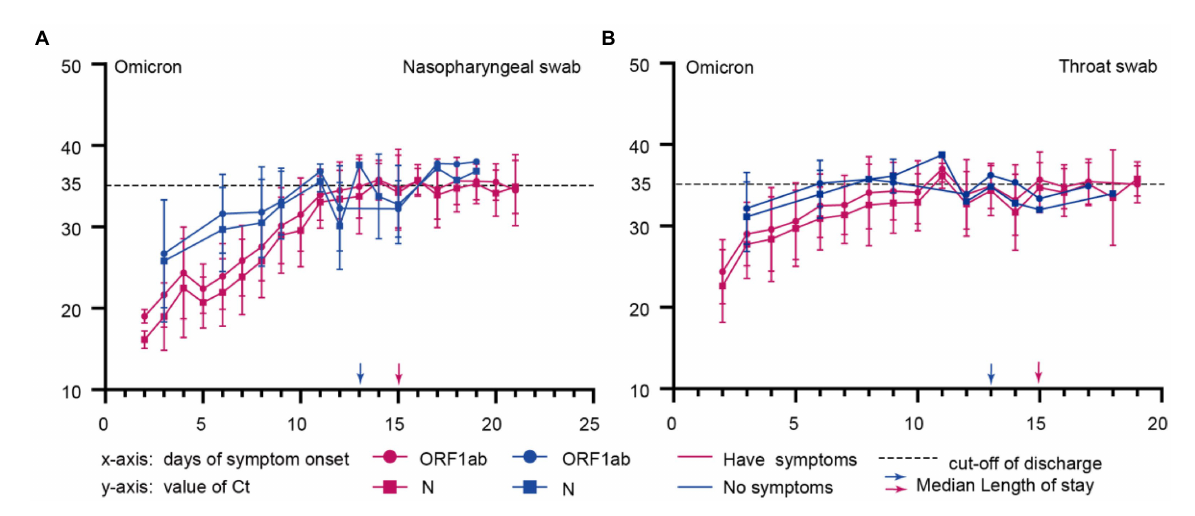
FIGURE 3 Comparison of Ct dynamic changes in omicron-infected patients with symptoms or no symptoms. (A) , Nasopharyngeal swabs of Omicron infected patients with symptoms or no symptoms; (B) , Throat swabs of Omicron infected patients with symptoms or no symptoms; The x-axis represents the time of disease course since symptom onset, and the y-axis shows the Ct values for Omicron infected patients with symptoms or without symptoms. Blue and red represent asymptomatic and symptomatic infected persons, respectively.